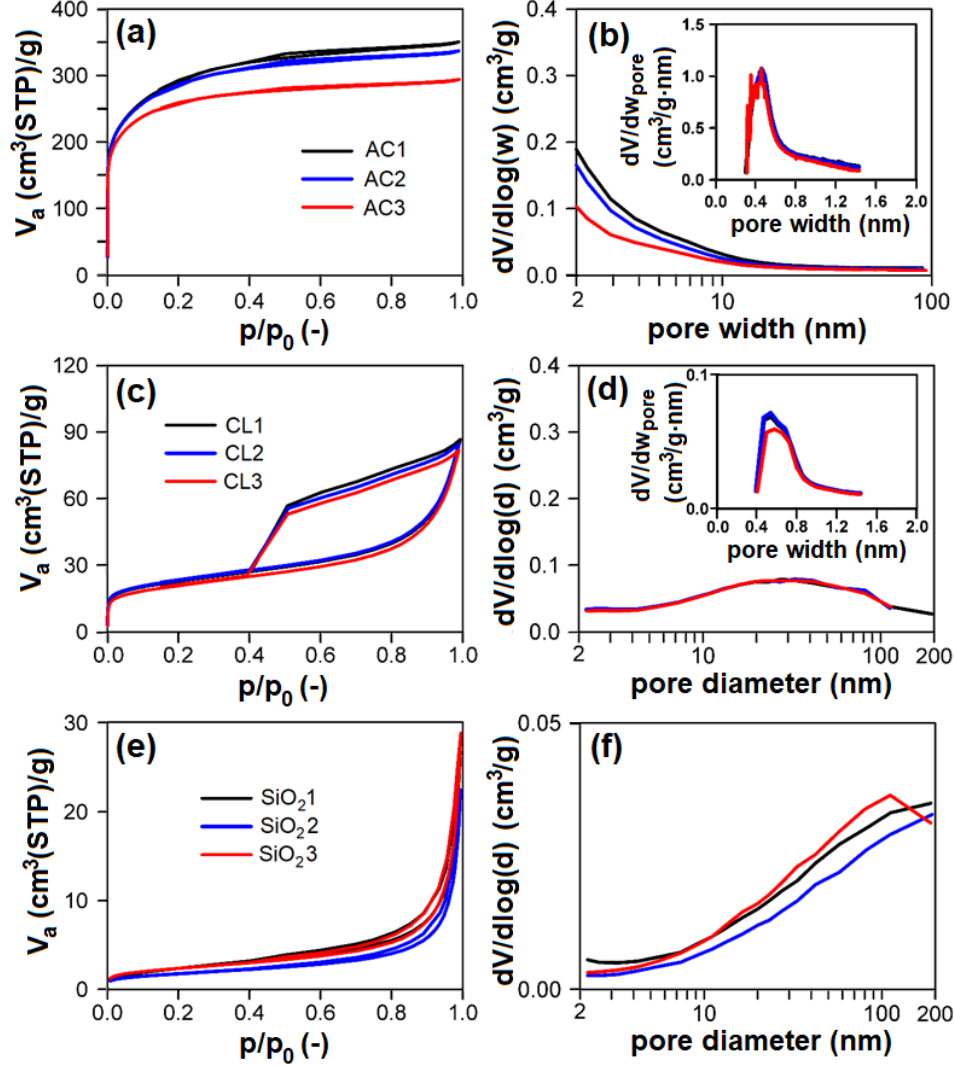
Figure 6. (left: ( a , c , e )) Measured nitrogen adsorption–desorption isotherms at 77 K, (right: ( b , d , f )) evaluated mesopore–macropore-size distributions of adsorbents and (inset) evaluated micropore size distributions of adsorbents: ( a , b ) AC; ( c , d ) CL; ( e , f ) SiO 2 . AC1-3, CL1-3, SiO 2 1-3—activated carbon, clay, and silicon dioxide respectively (1-3—three granulometric fractions; see Table 1), V a —adsorbed volume of nitrogen, STP—standard temperature and pressure, p/p 0 —relative pres- sure, dV/dlog(w) —derivation of adsorbed volume of nitrogen divided by derivation of logarithm of pore width, dV/dw pore —derivation of adsorbed volume of nitrogen divided by derivation of pore width, dV/dlog(d) —derivation of adsorbed volume of nitrogen divided by derivation of logarithm of pore